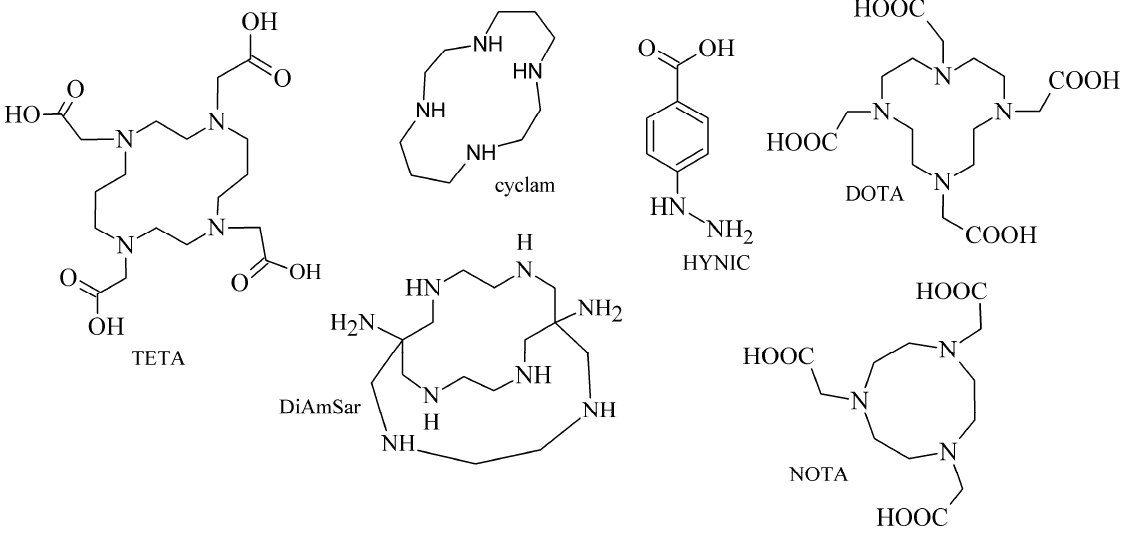
Figure 3. Chemical structures of the most common cyclic chelators as a base of BFCA. 3. Complexes and Radiolabeling Approaches for Target-Specific Peptide Molecules